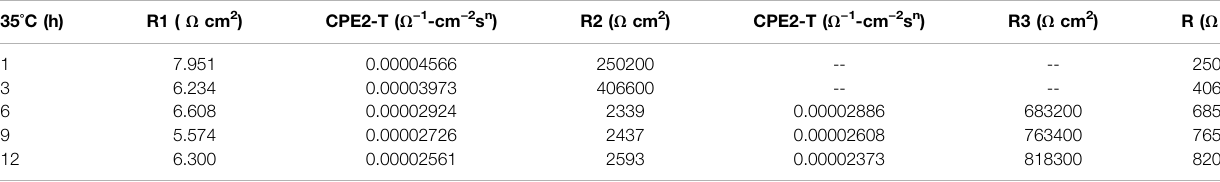
TABLE 4 | Impedance fi tting data of base metal area soaked in arti fi cial seawater at 35 ° C for 12 h 35 ° C (h)